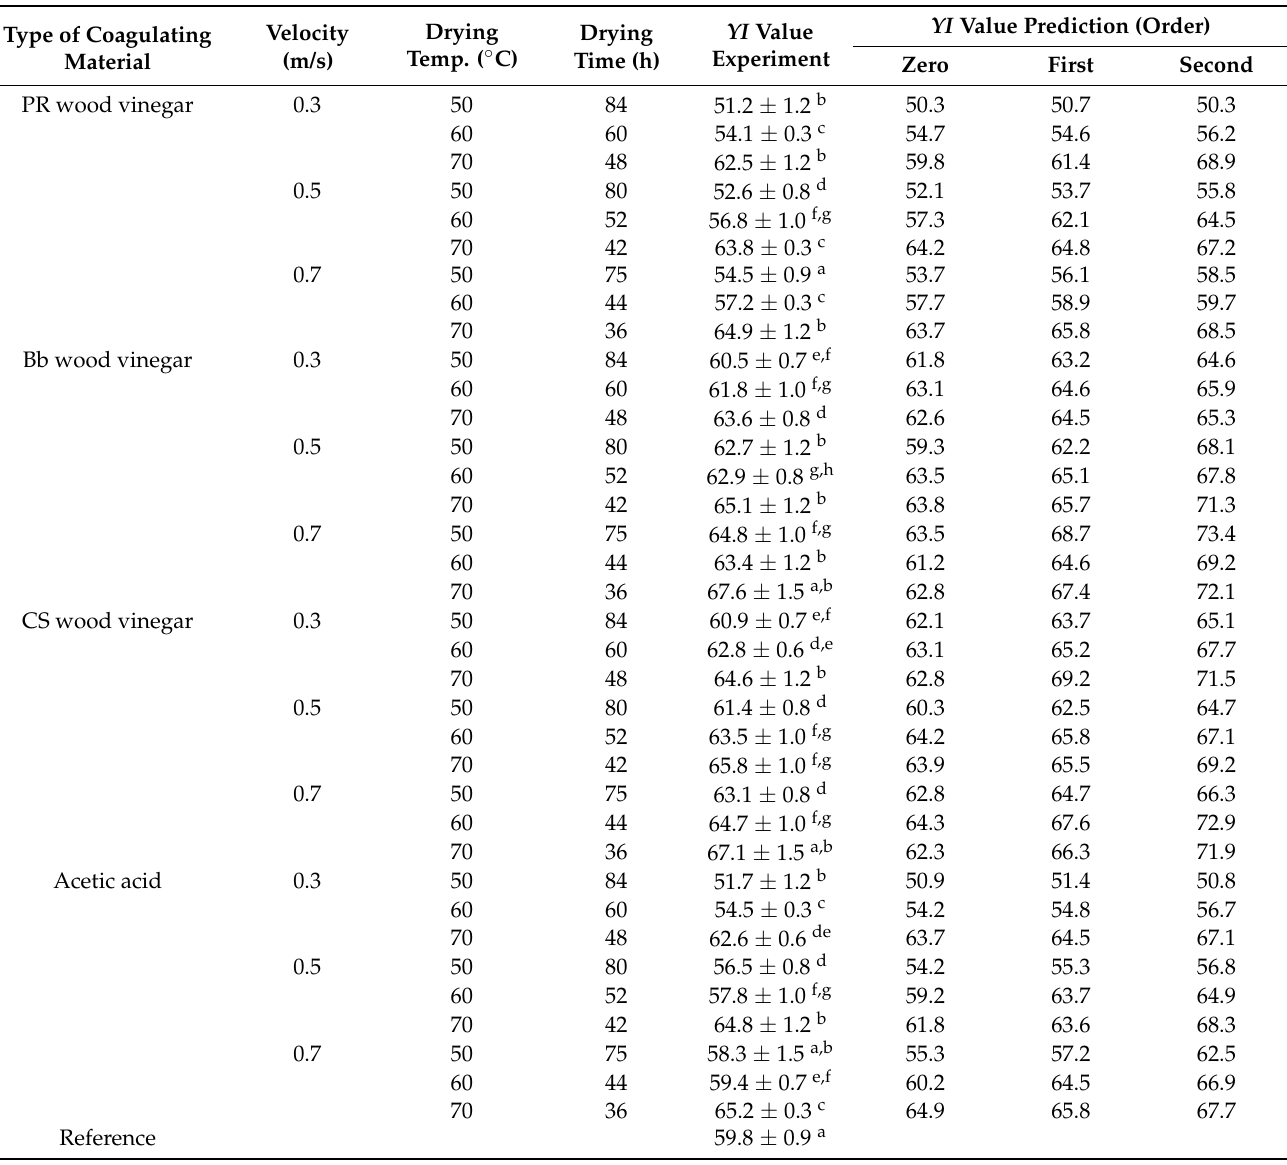
Table 2. The experimental and predictable YI value of the NR sheet samples at the final moisture content and the total drying time (temp. = temperature, PR = para rubber, Bb = bamboo, and CS = coconut shell). Velocity Type of Coagulating Material PR wood vinegar